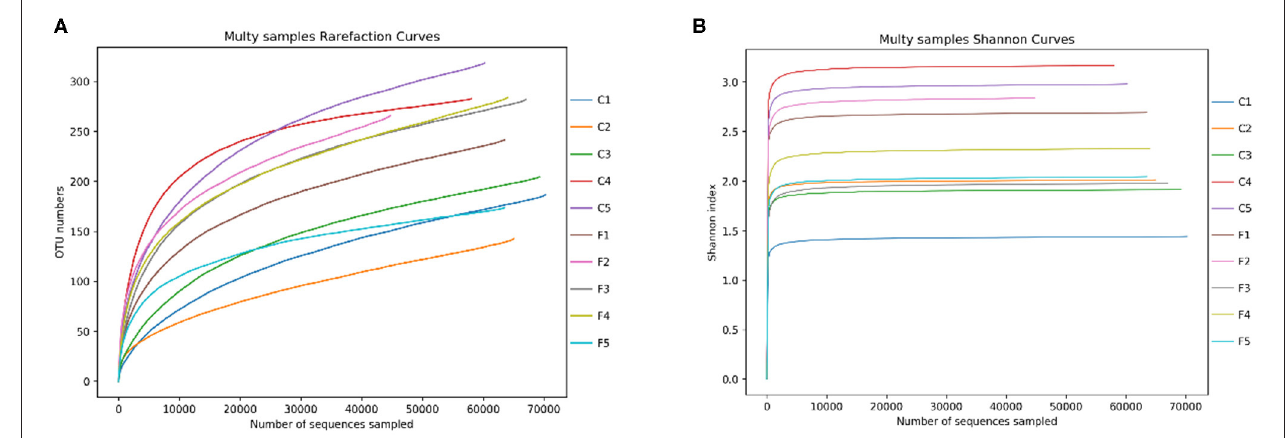
FIGURE 2 | The rarefaction curves of OTUs (A) and Shannon index for the 10 samples (B) . C1–C5 represent the samples collected in Sanmenxia, and F1–F5 represent the samples collected in Rongcheng.